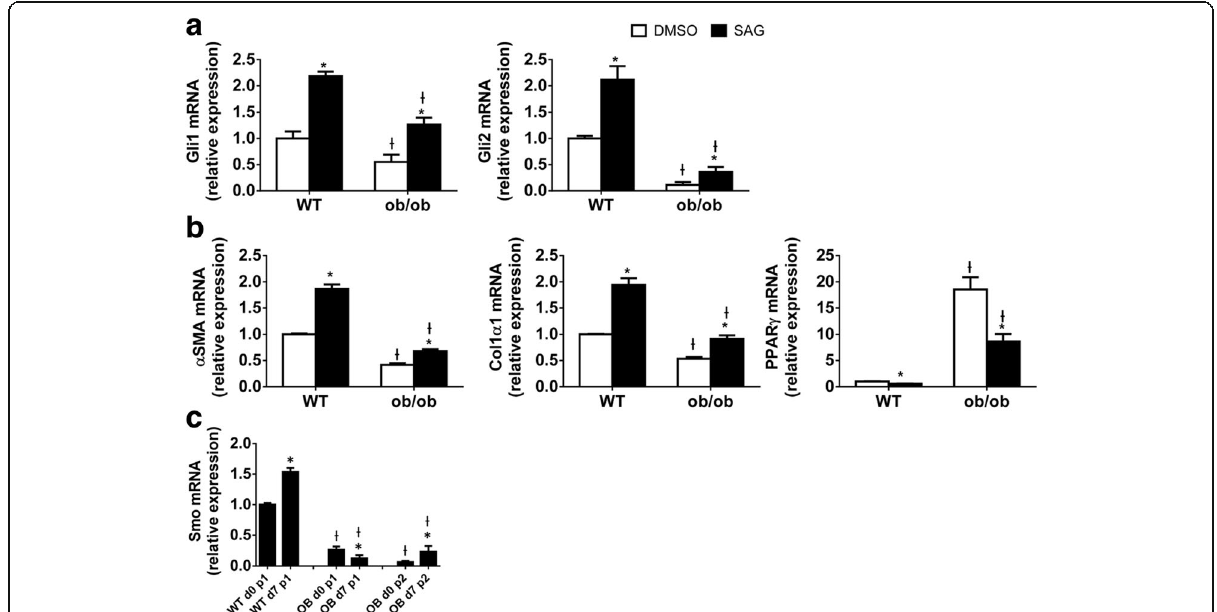
Fig. 6 Smoothened Agonist Activates Hh Signaling and Improves Phenotype of Leptin-deficient HSCs. Primary HSCs isolated from either WT or ob/ob mice were cultured in serum-containing medium for 4 days to induce activation and then treated with SAG (0.3 μ M, a Smo agonist that activates Hh signaling) or DMSO for 3 additional days. RNA was isolated, and changes in ( a ) Hh target genes (Gli1 and Gli2), ( b ) MF ( α SMA and Col1 α 1) and quiescence (PPAR γ ) gene expression were evaluated by qRT-PCR. Results were normalized to WT HSCs treated with DMSO. Ɨ p < 0.05 vs WT, * p < 0.05 vs vehicle. c Ultrapure HSCs were obtained by retinoid-based FACS of Nycodenz-gradient purified HSCs from WT and ob/ob mice; RNA was isolated from both freshly FACS-sorted cells (d0) or 7 day cultured FACS-sorted cells (d7), and Smo gene expression was examined